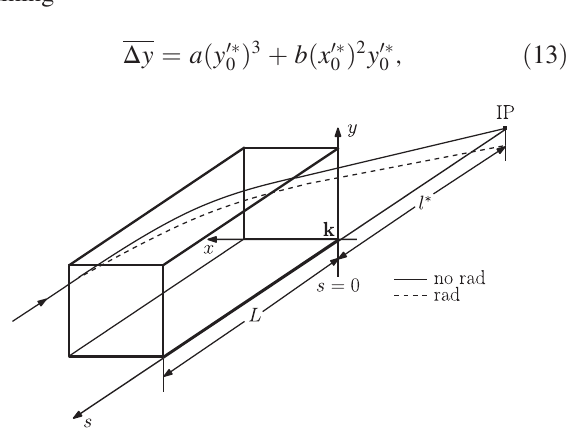
FIG. 3. The solid and dashed lines represent the particle trajectory without and with radiation,